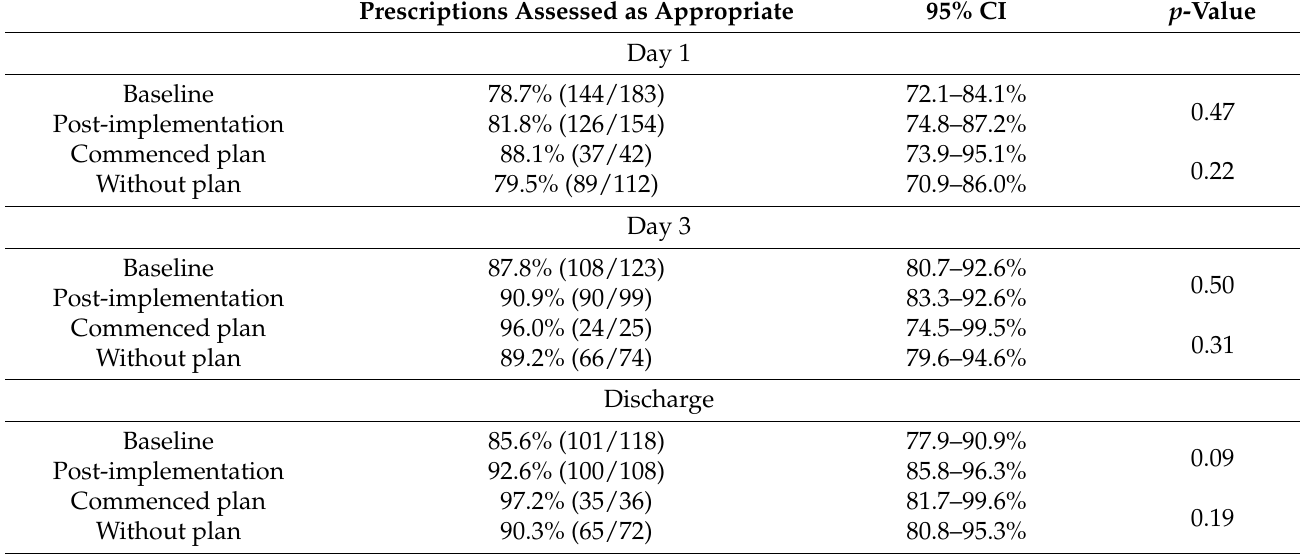
Table 2. Prescriptions assessed as appropriate using the NAPS definitions at day 1, day 3, and discharge at baseline and post- implementation of the cellulitis management plan.